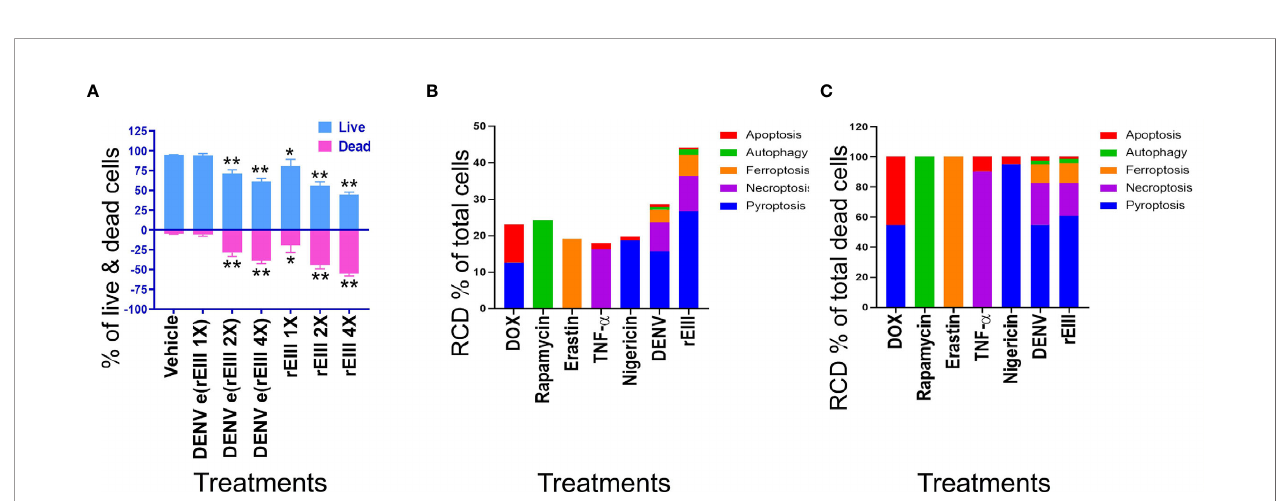
FIGURE 3 | DENV- and rEIII-induced RCD in platelets. (A) Washed mouse platelets treated with vehicle and various doses of DENV and rEIII; the live and dead cell populations were estimated using Zombie-NIR Kit labeling and fl ow cytometry analysis. [rEIII: 1× = 0.3 m M, 2× = 0.6 m M, 4× = 1.2 m M; DENV e(rEIII 1×) is a DENV level equivalent to 0.3 m M rEIII, as indicated by the methods described in Figure S8 ]. (B) RCD inducers, doxorubicin (DOX; apoptosis) (2.5 m g/ml), rapamycin (autophagy) (0.5 m M), erastin (ferroptosis) (10 m M), TNF- a (necroptosis) (2.5 ng/ml), and nigericin (pyroptosis) (3.5 m M) induced relatively simple RCD patterns. By contrast, DENV and rEIII induced multiple RCD pathways, in which pyroptosis is the major RCD response, with counts approximately 60% of total RCD (B) . If we normalize the respective RCD by the population of death cells (dead cell population normalized to 100%), we can obtained a more similar RCD pattern in DENV and rEIII groups (C) . * P < 0.05, ** P < 0.01 vs. vehicle